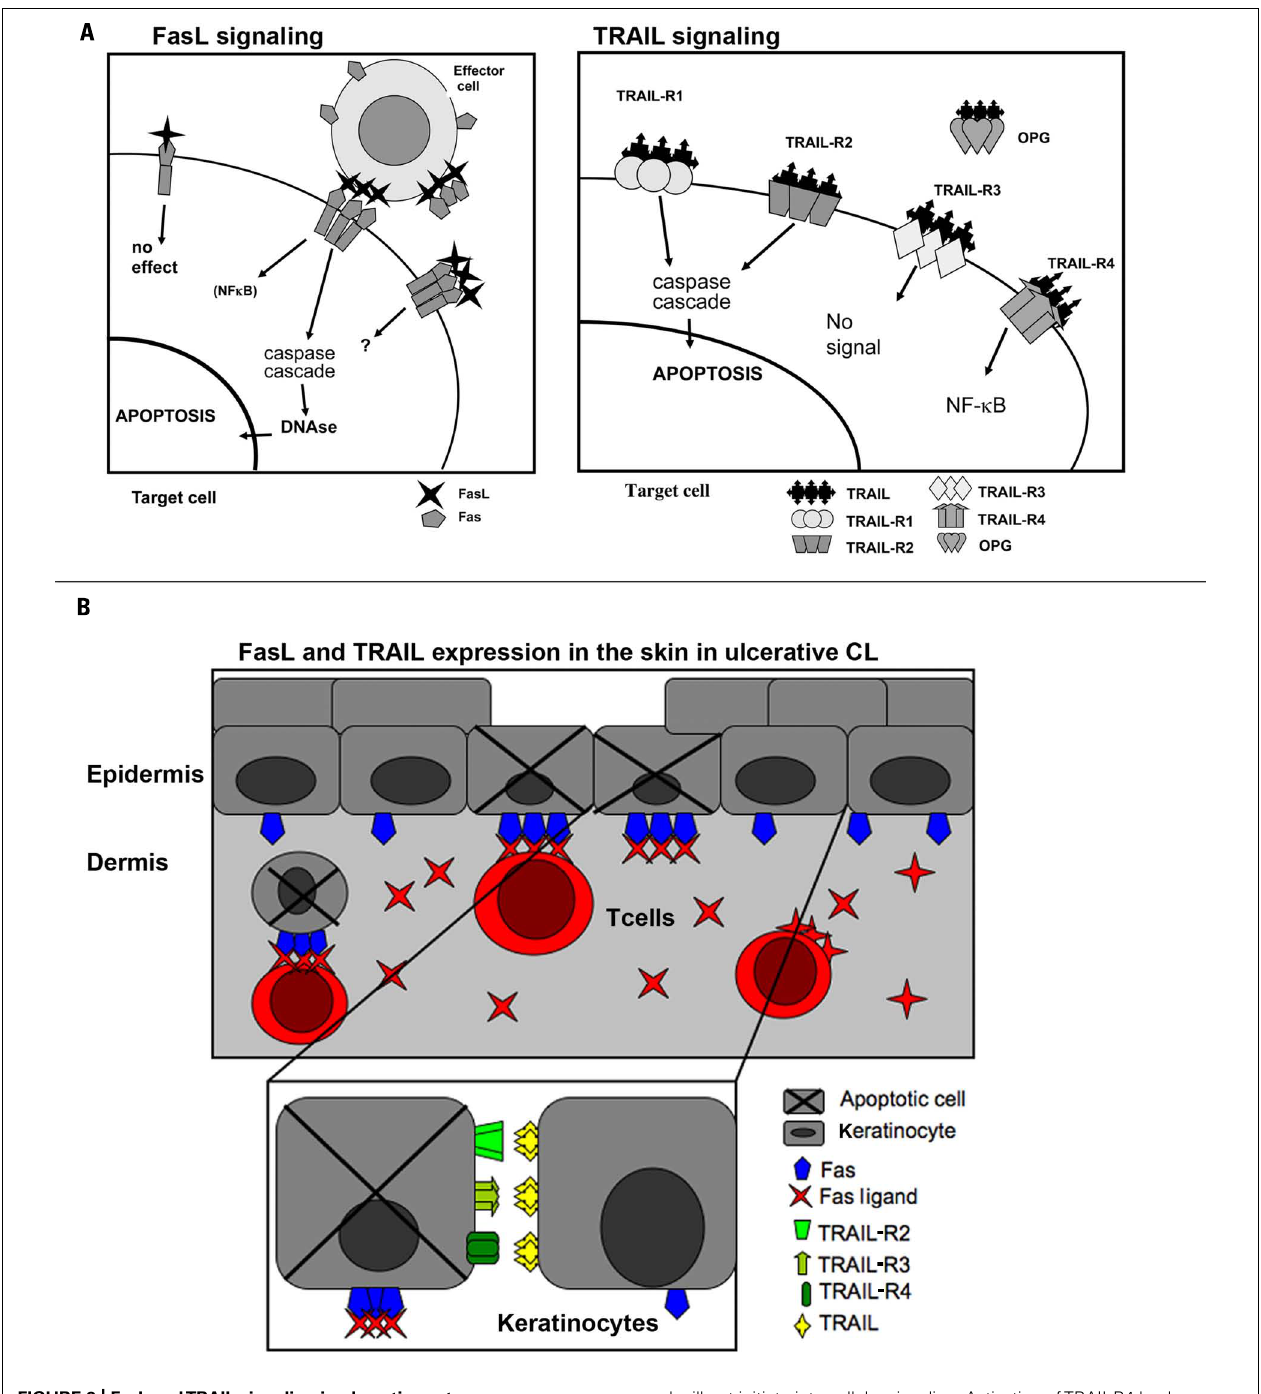
FIGURE 2 | FasL andTRAIL signaling in ulcerative cutaneous leishmaniasis. (A) FasL andTRAIL signaling induce apoptosis or proinflammatory signaling depending on the receptor expression on the target cell. (Left) Fas is expressed as a homodimer on cell-surfaces. Upon FasL ligation to trimerized Fas caspase activation leading to apoptosis is initiated. Fas may also lead to NF- κ b activation. sFas probably serves as a negative modulator of FasL.The function of sFasL is debated and it has been suggested that the concentration will determine if apoptosis can be triggered through Fas by sFasL. (Right) Apoptosis is induced throughTRAIL activation ofTRAIL-R1 and -R2.TRAIL-R3 is a decoy